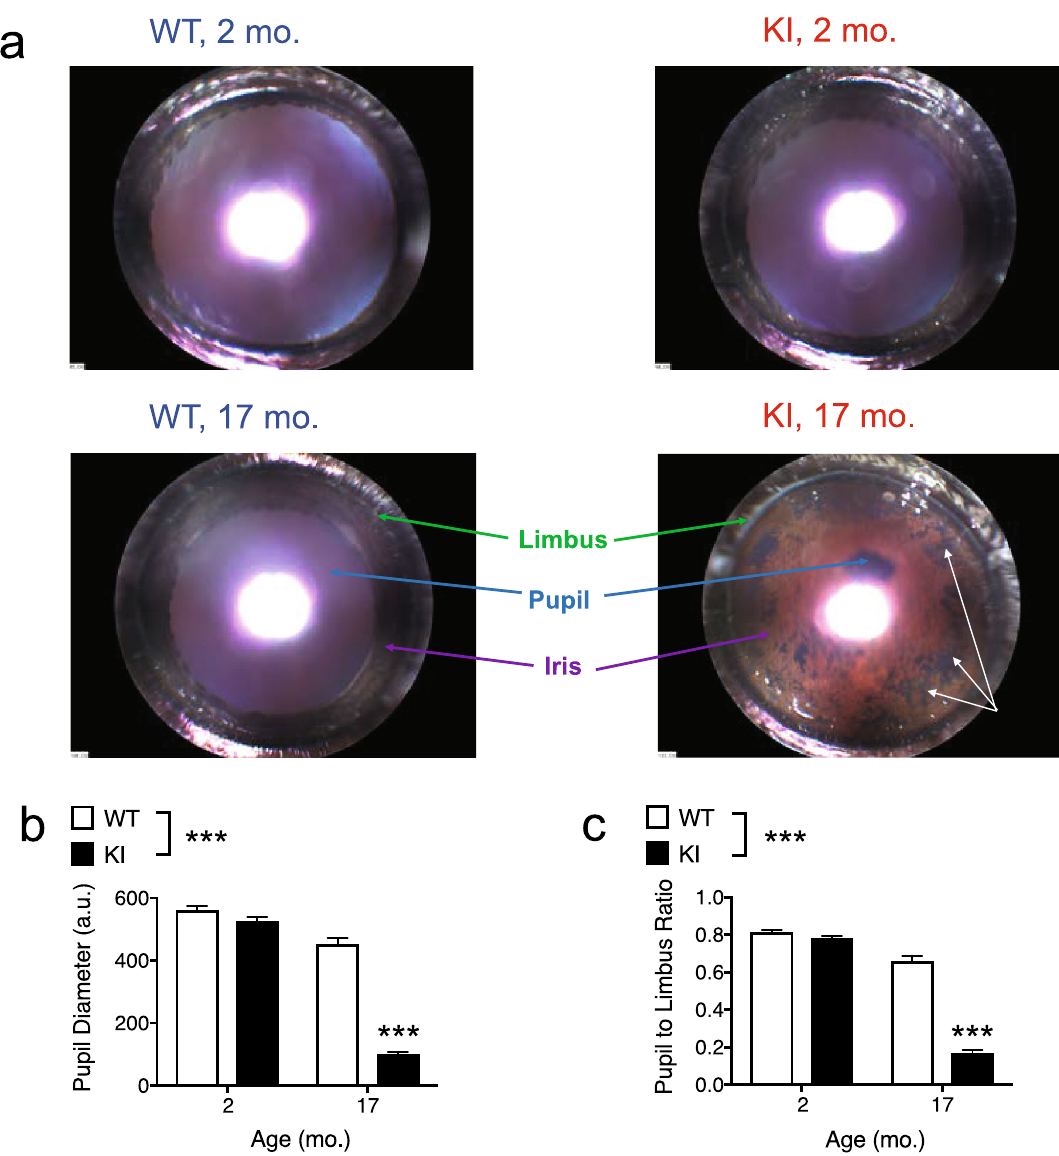
Figure 2. Pupil dilation deficits in response to tropicamide in aged Gba KI mice. ( a ) Representative images of the anterior segment in anesthetized 2- versus 17-months old Gba KI and WT mice following tropicamide treatment. The bright spot in the middle area of the images are reflections of the axial light illumination. The arrows indicate cracks and holes in the iris of a 17-months old KI mouse. ( b ) Pupil diameter following tropicamide treatment measured from ( a ). ( c ) Pupil to limbus diameter ratio measures were calculated to normalize pupil measures relative to limbus diameter, a proxy measure fore eye size. a.u. arbitrary units. Asterisks denoting significance levels for main effects of genotype are indicated next to the genotype symbols above the graphs; those for post-hoc tests between individual genotype- and age-combinations are indicated within the graphs. Main effects of age are not indicated. *** p < 0.001. Values are mean ±